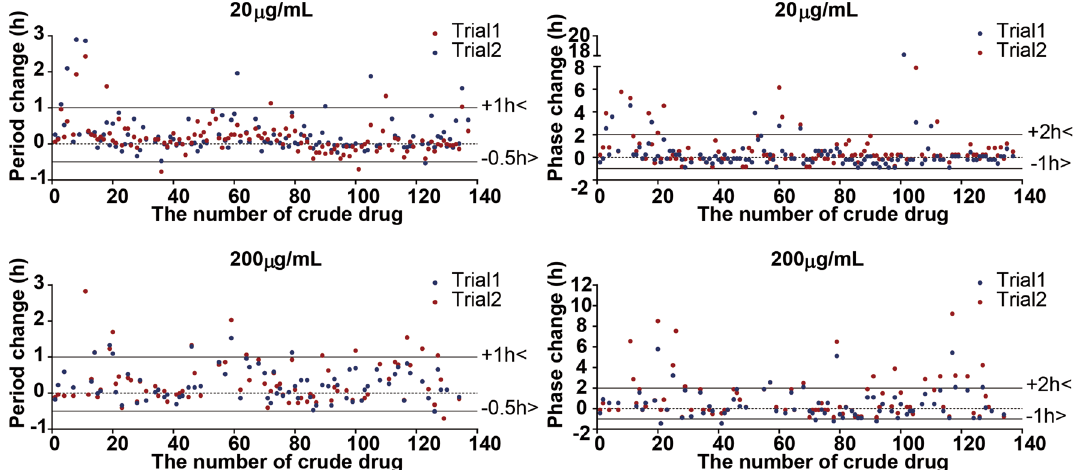
Figure 1. Screening of crude drug extracts for circadian clock modulators. A total of 137 crude drug extracts were screened in Bmal1-dluc U2OS cells at 20 µg/mL (top) and 0.20 mg/mL (bottom) for circadian period (left) and phase (right) changes. (Left) Two independent trials identified two crude drugs at 20 µg/mL and four crude drugs at 0.20 mg/mL that show consistent period lengthening effects by 1 or more hours. (Right) This screening also identified five crude drugs at 20 µg/mL and eight crude drugs at 0.20 mg/mL that show consistent phase changing effects by 2 or more hours.